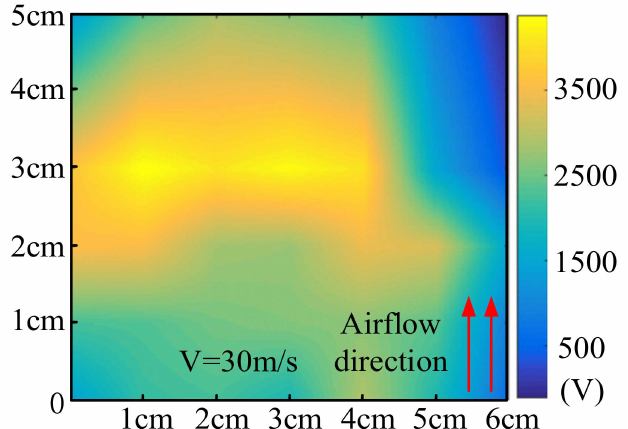
Figure 15. Charge distribution when the airflow speed is 30 m/s.